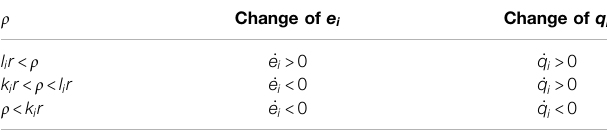
TABLE 1 | The behaviors of fi rms for welfare